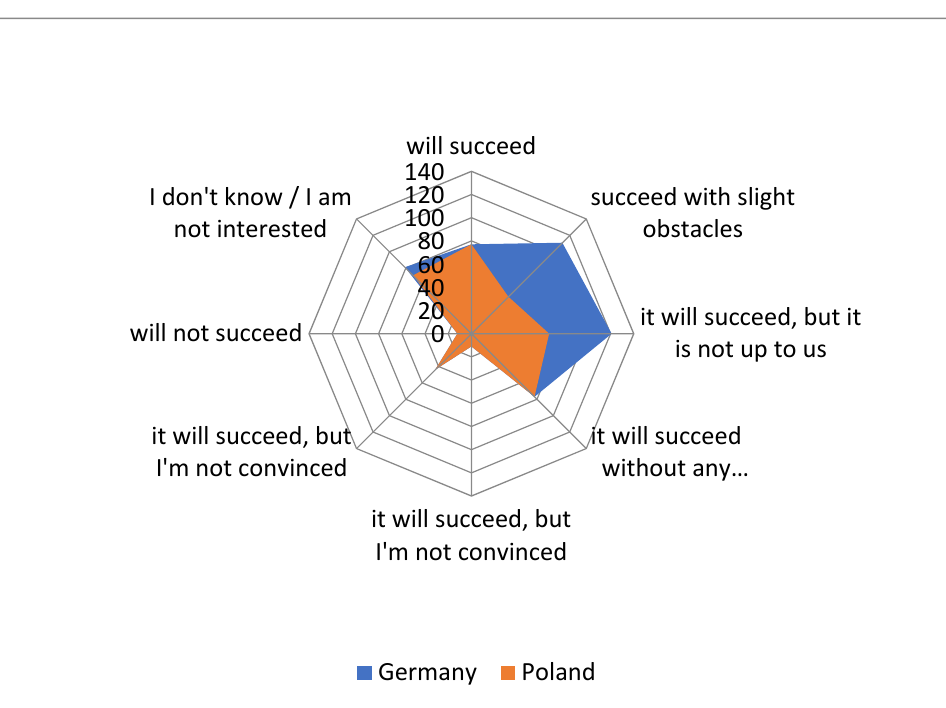
Figure 21. Opinion of married individuals (not conducting business activity) in Poland and Germany. Figure 22 below presents the opinions of an independent individual (without a couple).